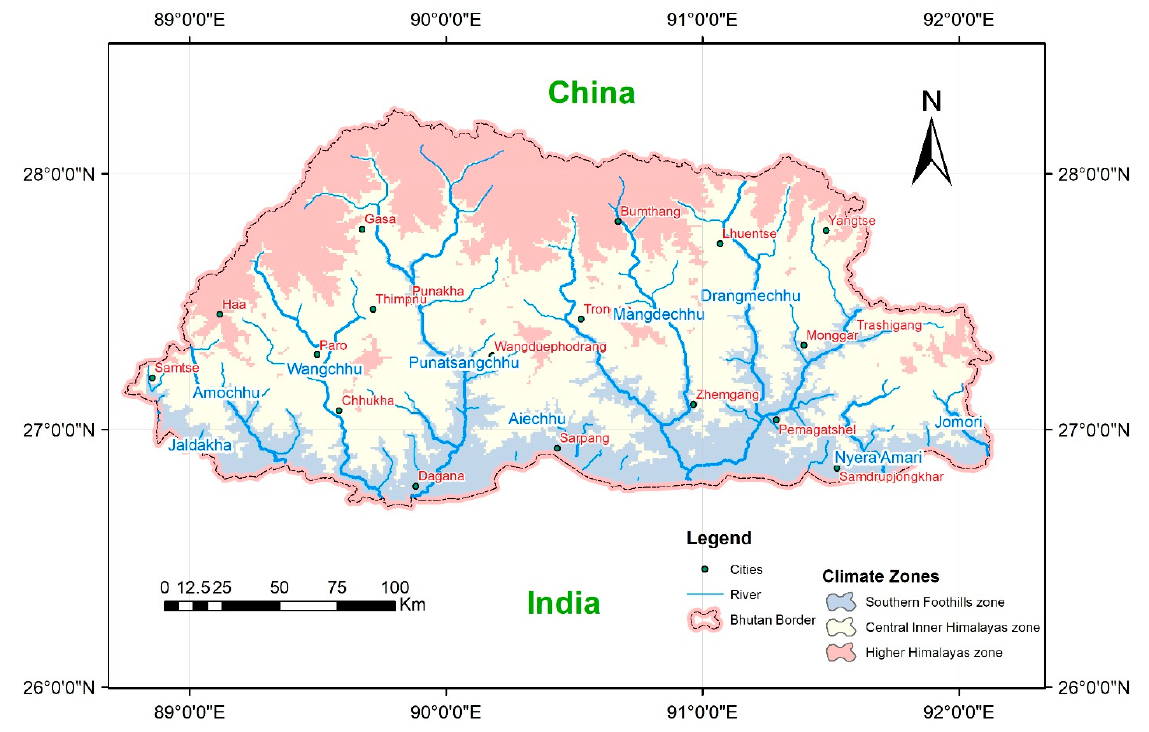
Figure 2. Map showing different climatic zones of Bhutan.